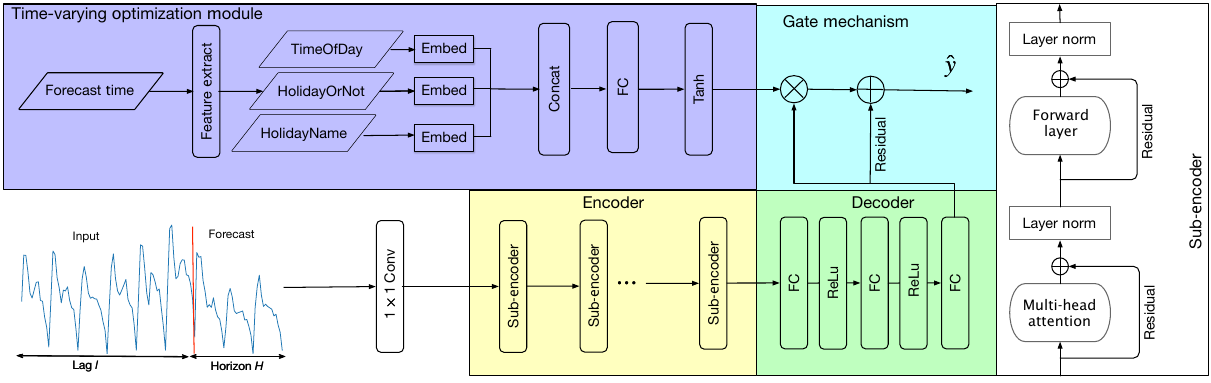
Fig. 3 Framework of